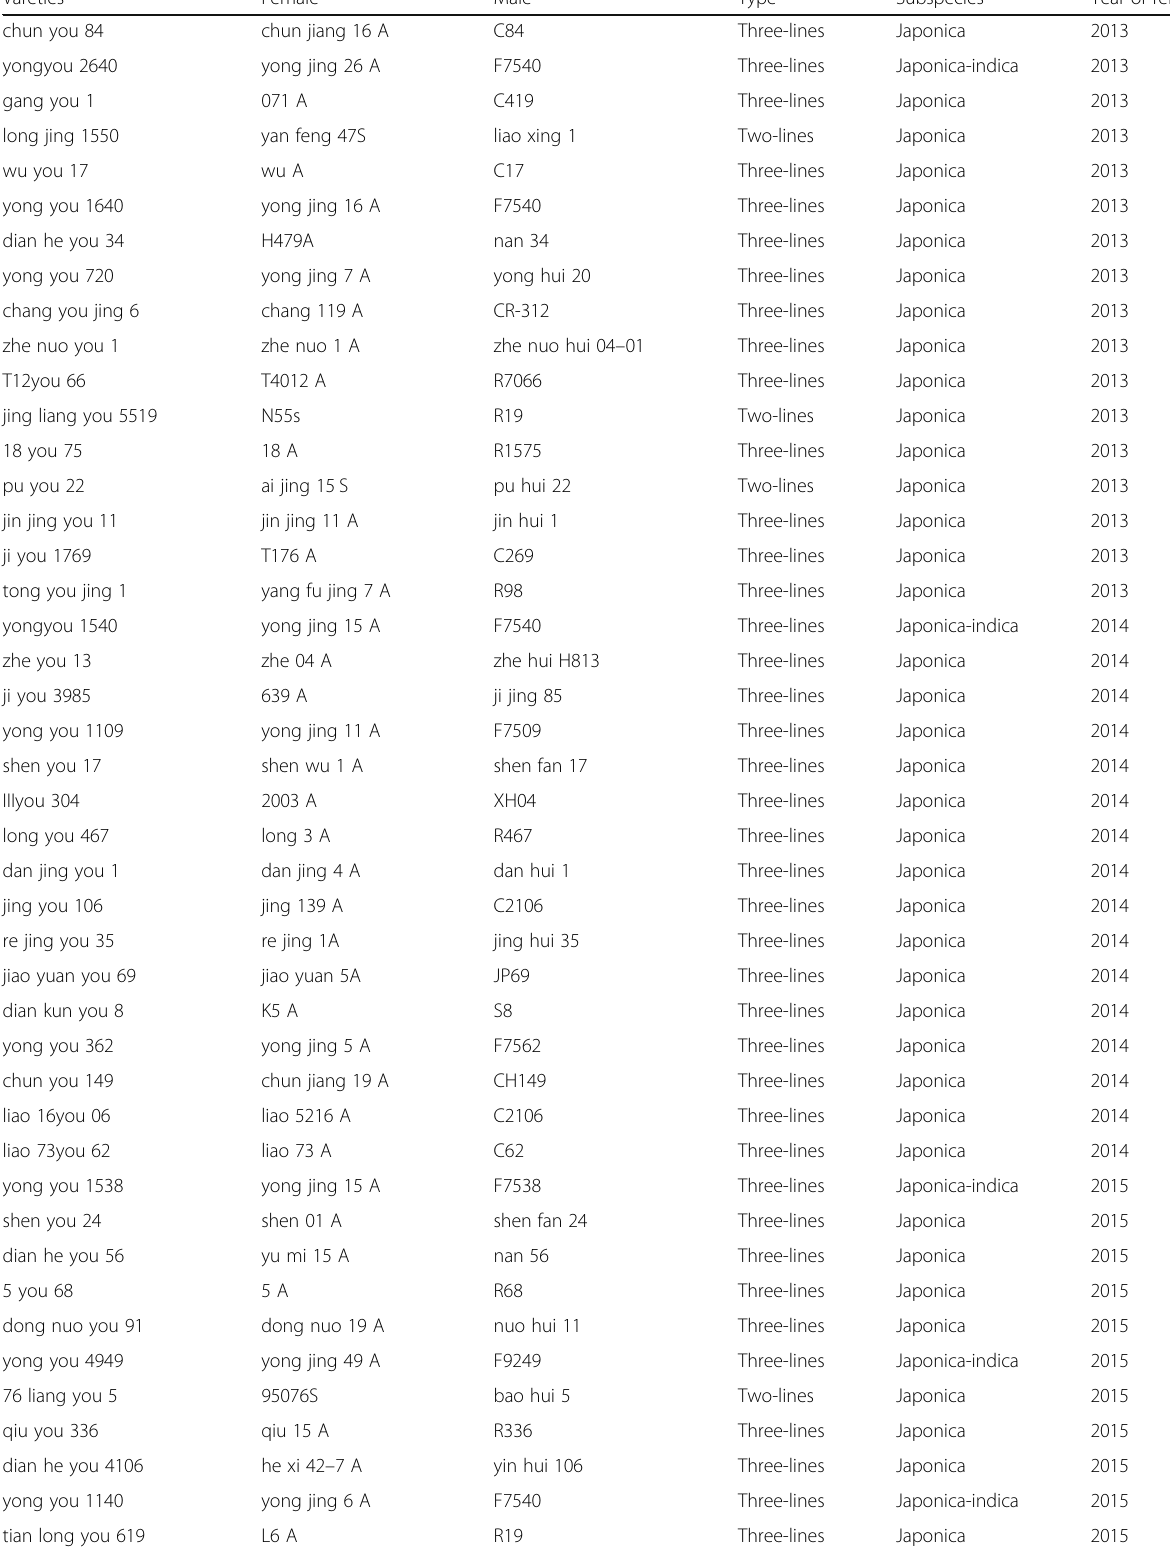
Table 1 List of hybrid japonica rice varieties bred in China (Continued)